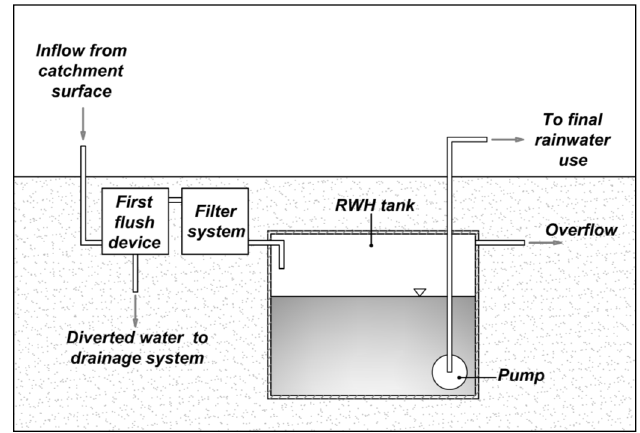
Figure 8. Schematic underground installation of the RWH system.